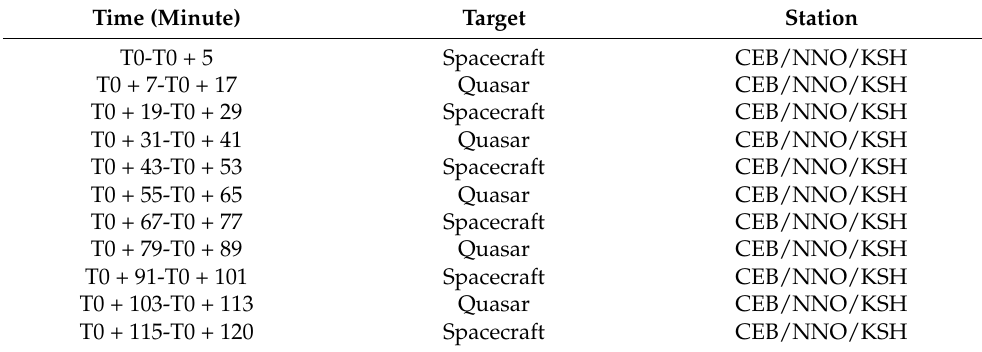
Table 2. Typical cross ‐ support session schedule.